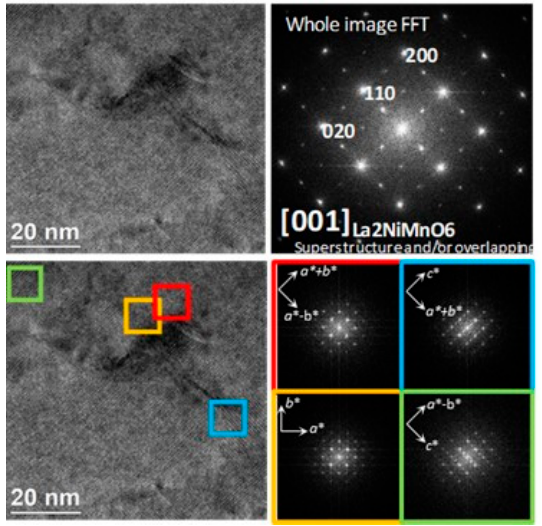
Figure A2. A plan-view HRTEM image of LNMO900 °C thin film. Fourier transform (FT) shows the coexistence of nanodomains with different orientations.